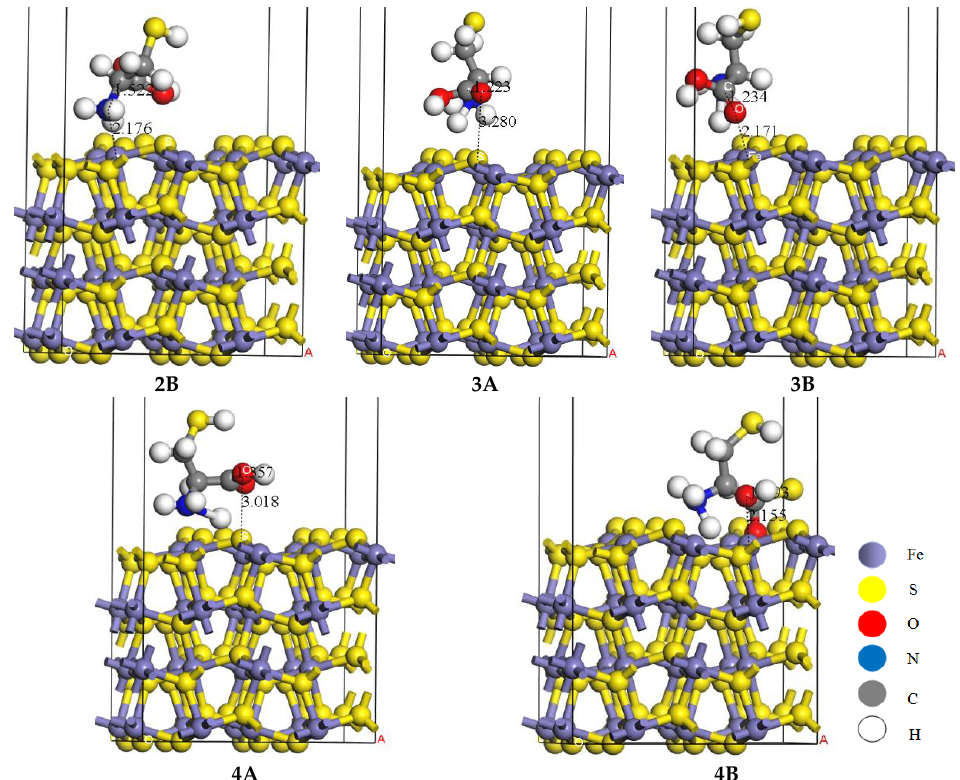
Figure 3. The optimized configuration of cysteine adsorbed on the pyrite (1 0 0), showing with -SH ( 1A / 1B ), -NH 3 ( 2A / 2B ), =O (-C=O, 3A / 3B ), -O (-C-OH, 4A / 4B ) of cysteine adsorbed on the S/Fe site of pyrite (1 0 0), respectively. Table 3. The lengths (<3.5 Å) between adsorbed atoms of cysteine and pyrite (1 0 0) in optimized